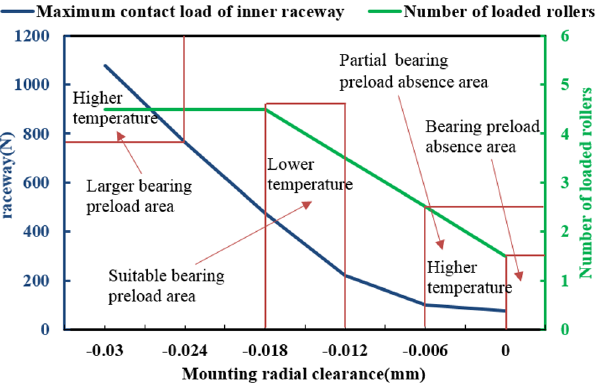
Fig. 12. The preload characteristics and temperature trend prediction of bearing under the different outer raceway waveform